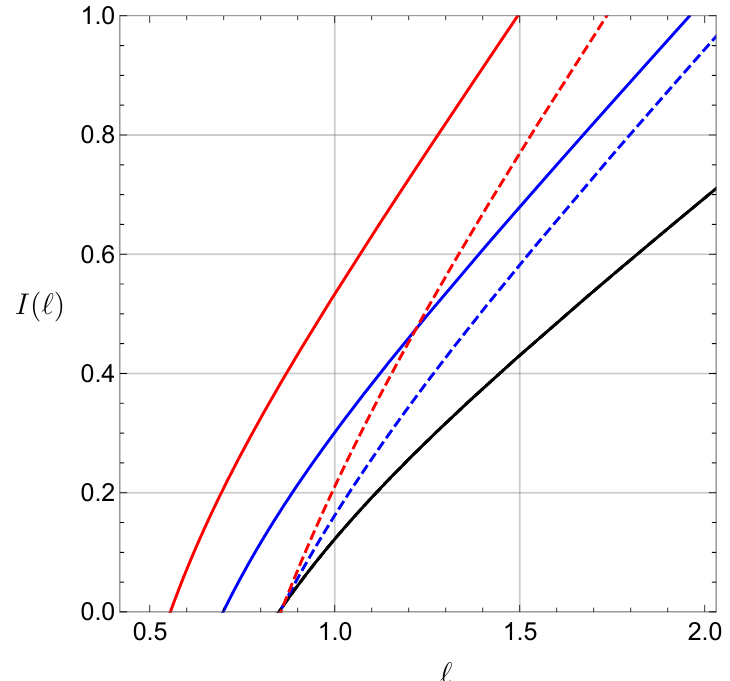
Figure 4 . Mutual Information (in units of V 2 =G ) as a function of ‘ for the MT model. The N curves correspond from the right to the left to a=T = 0 (black curve), a=T = 8 : 56 (blue curves) and a=T = 21 : 57 (red curves). The continuous/dashed curves represent the result for a strip orthogonal/parallel to the anisotropic direction. Here we have (cid:12)xed T = 1 =(cid:25)